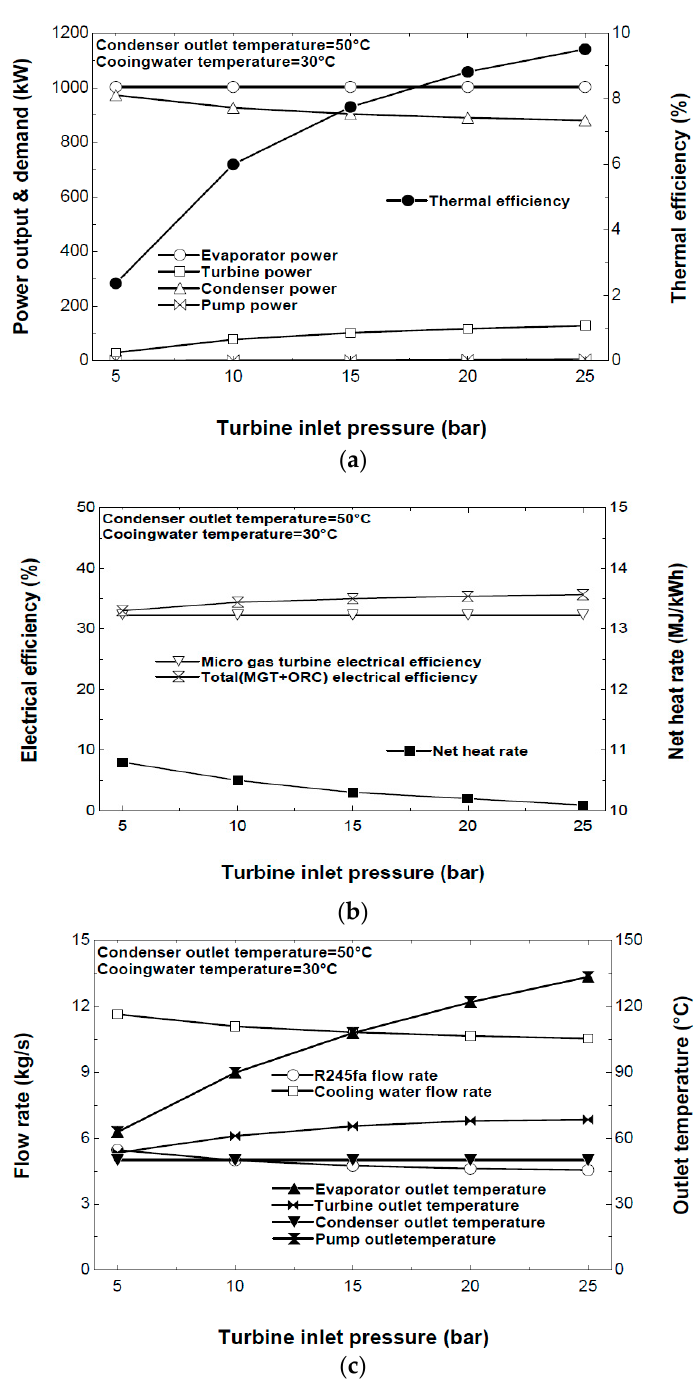
Figure 5. The effect of the turbine inlet temperature to the performance and operating conditions of organic Rankine cycle. ( a ) The power output and demand for the ORC components and thermal efficiency of the ORC; ( b ) The electrical efficiency of the MGT and the MGT with the ORC. The net heat rate of the MGT with the ORC; ( c ) The mass rate and the outlet temperature for the streams in the ORC.